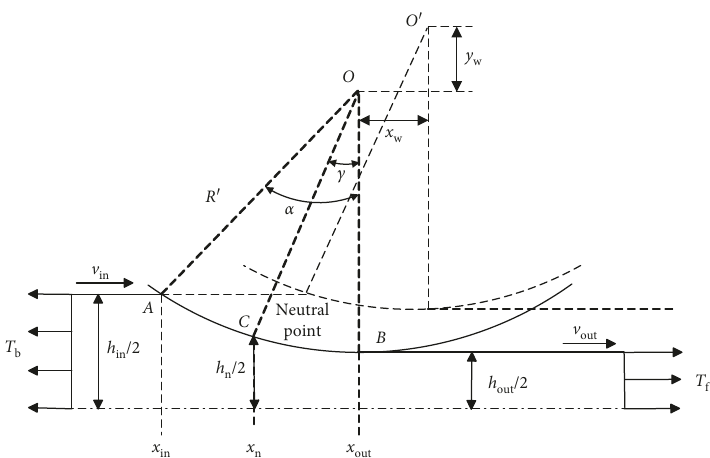
Figure 1: Vibration geometry model of the roll